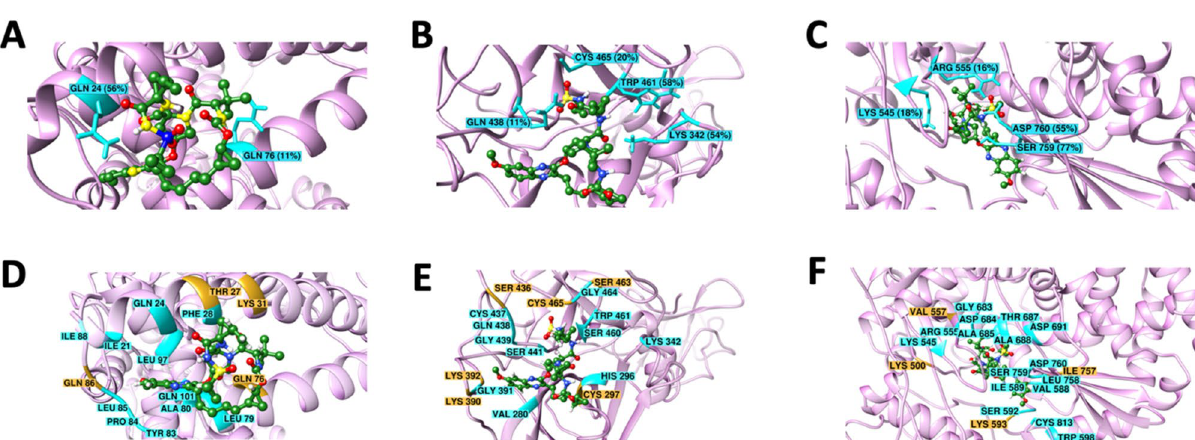
Figure 4. Residues involved in the formation of H-bond ( A , B , C ) and other non-covalent interactions ( D , E , F ) between ( A , D ) ACE2 and Grazoprevir ( B , E ) TMPRSS2 and Grazoprevir ( C , F ) RdRP and Grazoprevir. Residues forming H-bond that was stable for more than 10% simulation time are shown by the cyan stick in the ribbon diagram with respective stability. Other stable non-covalent interactions having more than 80% stability are shown by the cyan ribbon. Contacts having 60–80% stability are shown in orange color. Grazoprevir is shown in ball and stick representation, and carbon, oxygen, sulphur and hydrogen atoms are shown in green red, yellow and